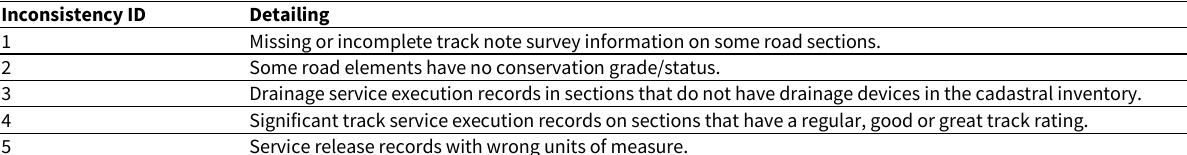
Service release records with wrong units of